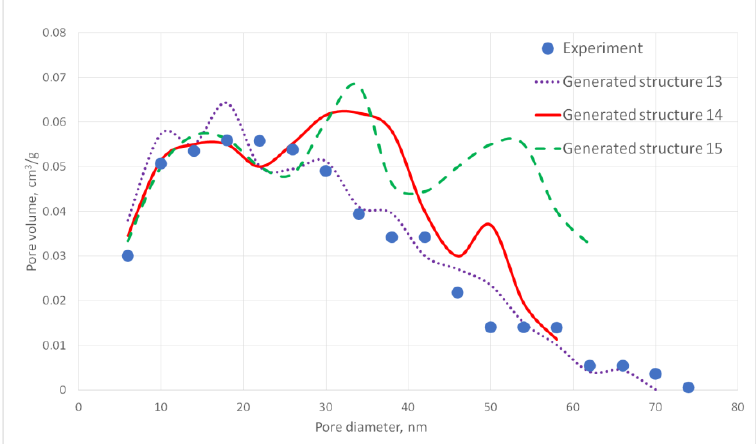
Figure 5. Pore size distribution curves for generated PA structures 10–12.